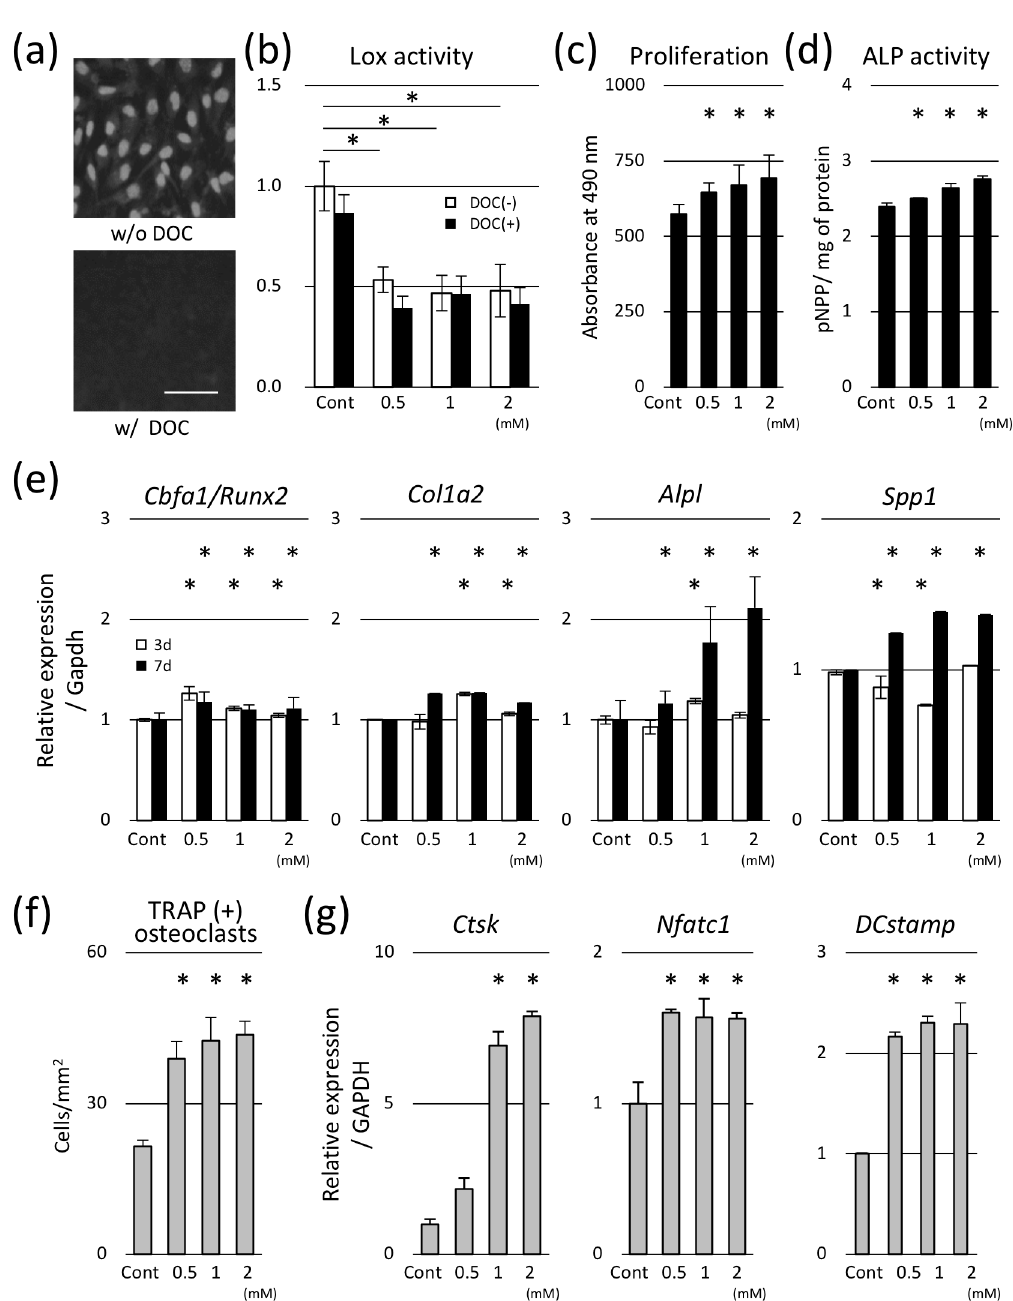
Fig 2. Effect of low cross-linked matrices on osteoblast and osteoclast. (a) The ablation of cellular components by DOC was confirmed by DAPI staining. Bar: 50 μm. (b)The Lox activity of prepared matrices before and after the DOC treatment was analyzed. The Lox activity was significantly decreased in the matrices produced by BAPN-treated cells. DOC treatment did not significantly affect the Lox activity of prepared matrices, regardless of the BAPN concentration. (c) The proliferation of MC cells was significantly increased in the low cross-link density matrices. (d) Alkaline phosphatase (ALP) activity increased in cells seeded on low cross-linked matrices. (e) Gene expression of Cbfa1/Runx2 , type I collagen α 2 chain ( Col1a2 ),alkaline phosphatase ( Alpl ), and osteocalcin ( Spp1 ) significantly increased in these matrices at 3 and 7 days of culture. (f) Osteoclasts were cultured on differentially cross-linked matrices for 6 days under the differentiation condition. The number of multi- nuclear tartrate-resistant acid phosphatase (TRAP)-positive cells increased in the low cross-link density matrices. (g) Gene expression of cathepsin K ( Ctsk ), nuclear factor of activated T-cells cytoplasmic 1 ( Nfatc1 ), and dendritic cell-specific transmembrane protein ( DCstamp ) increased in low cross-link density matrices. (cid:3) p < 0.05, compared to the control.